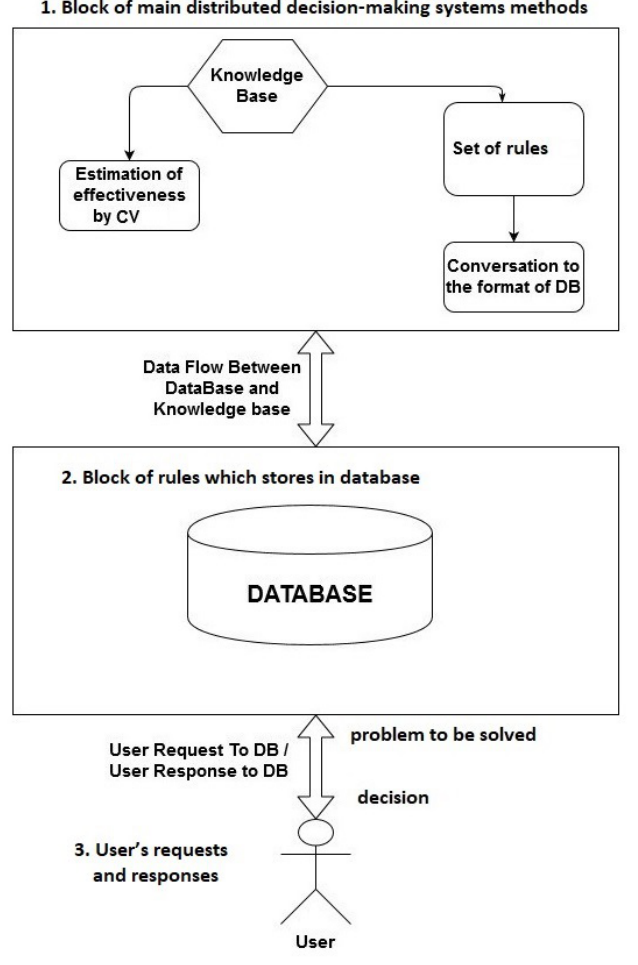
Figure 1. Basic scheme of the database system vs. rule-based knowledge based